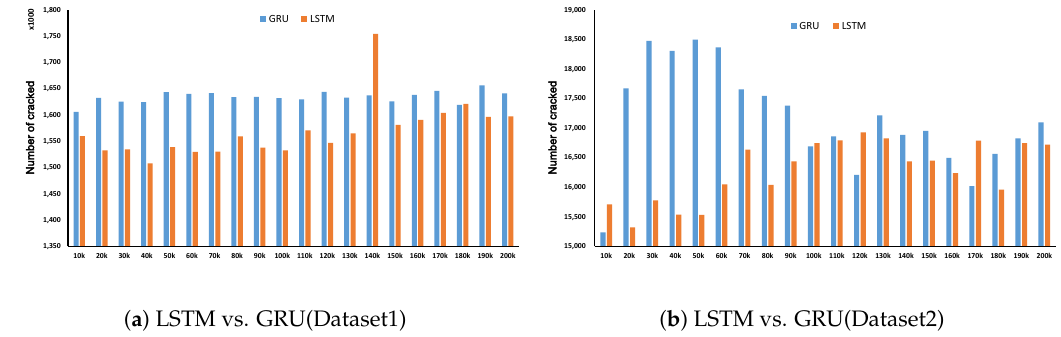
Figure 5. The GRU cell performed better than LSTM. Although LSTM exhibited a lower JSD value during training, it was outperformed by GRU, with respect to